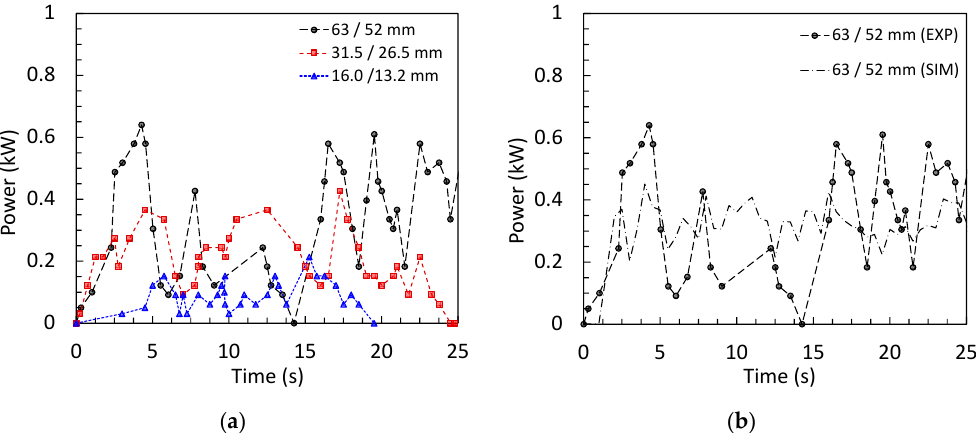
Figure 12. Measured ( a ) and comparison of measured and simulated ( b ) net power of the laboratory jaw